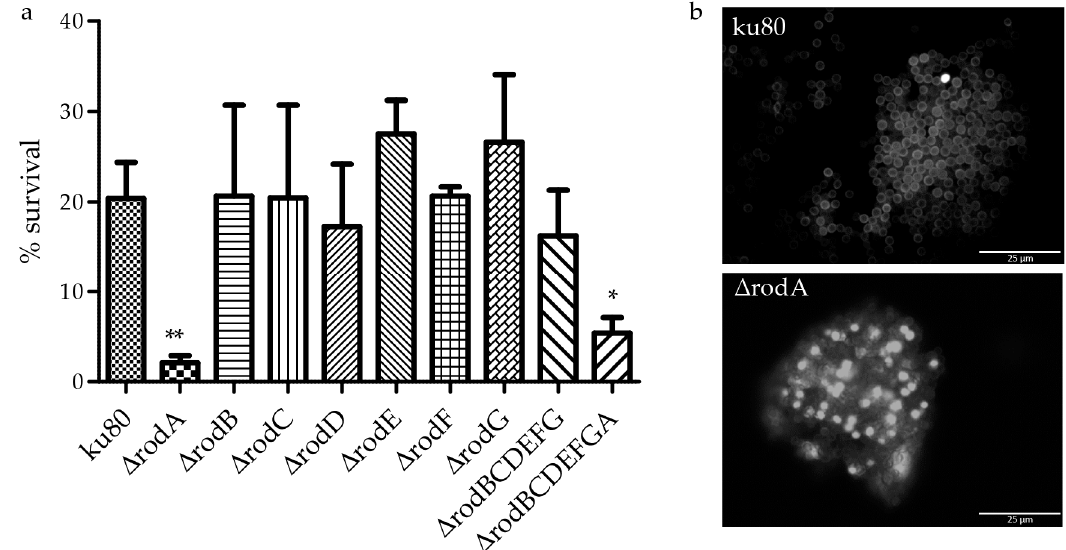
Figure 6. Resistance and permeability of the ∆ rodA conidial cell wall. After physical disruption of conidia by 0.17 mm beads for 1 min, conidial survival was estimated by CFU, * p < 0.05 ( a ); FITC labeling of ∆ rodA and ku80 conidia showing a modification of the cell wall permeability seen by the intracellular staining of many ∆ rodA conidia ( b ).